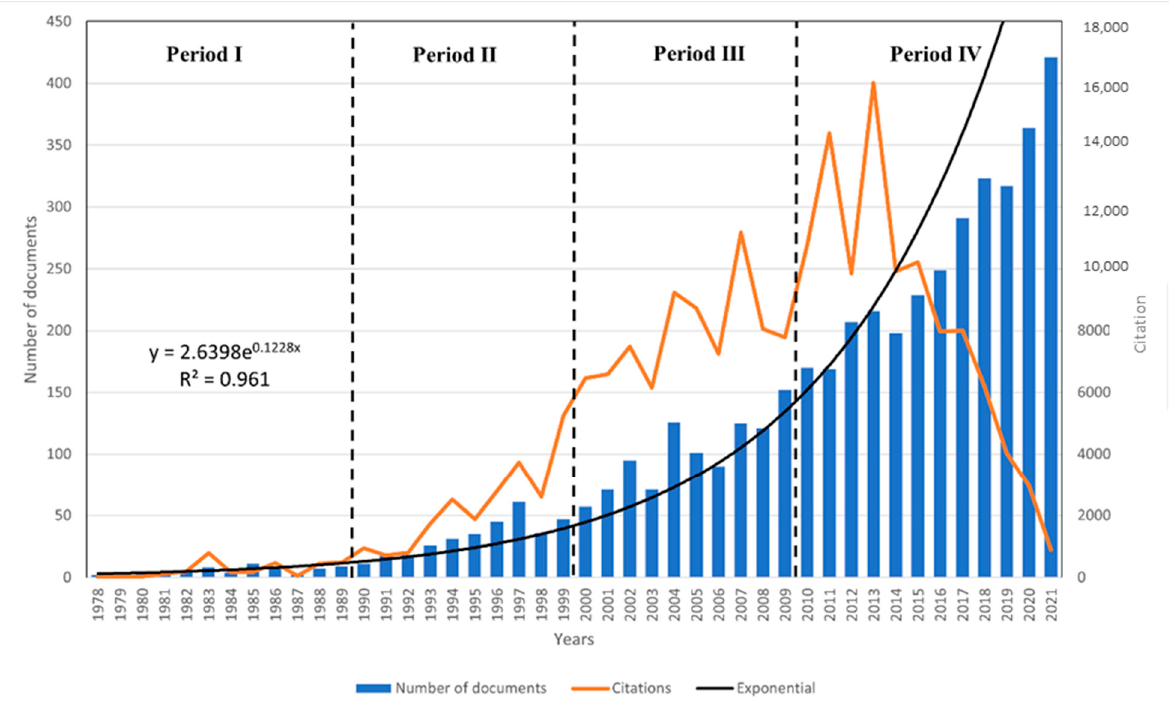
Figure 2. Scientific production in research (1978–2021) on LULC in tropical forests divided into four periods. The data are the annual number of papers (articles and reviews) indexed in Scopus and the number of citations per year.